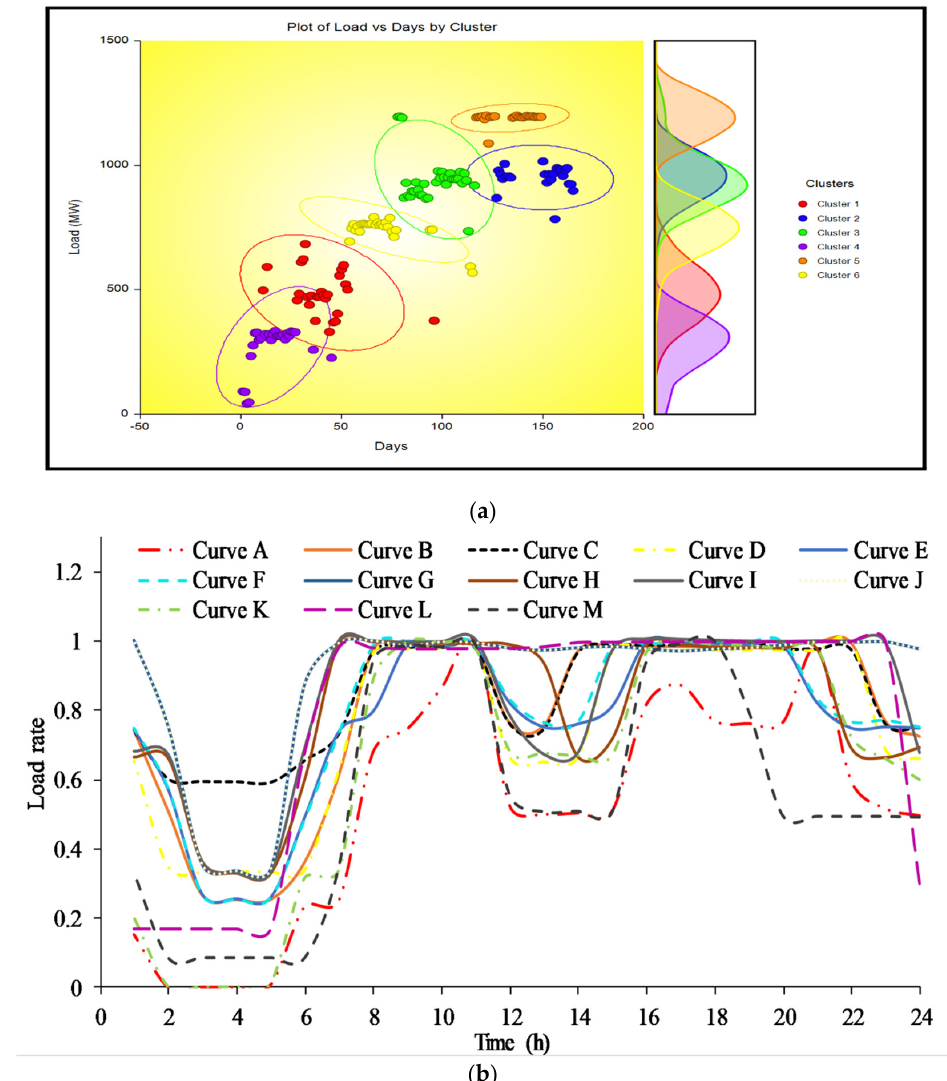
Figure 3. Tianshengqiao plant 1: ( a ) cluster analysis; ( b ) typical generation curves.